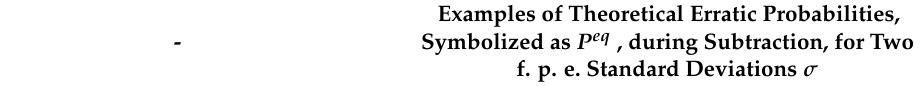
Table 1. The probabilities of the deterministic modification of normally distributed finite precision error. Examples of Theoretical Erratic Probabilities, - Symbolized as P eq , during Subtraction, for Two f. p. e. Standard Deviations σ Second std of the First std of the Number of erroneous d. d. randomly Gaussian pdf Gaussian pdf generated during subtraction σ 2 = 4.9 σ 1 = 1.65 Increased by one 6.20 × 10 − 3 % 14.31% Retained the same 68.27% 68.66% Reduced by one 28.06% 10.86% Reduced by two 3.53% 1.05% Reduced by three